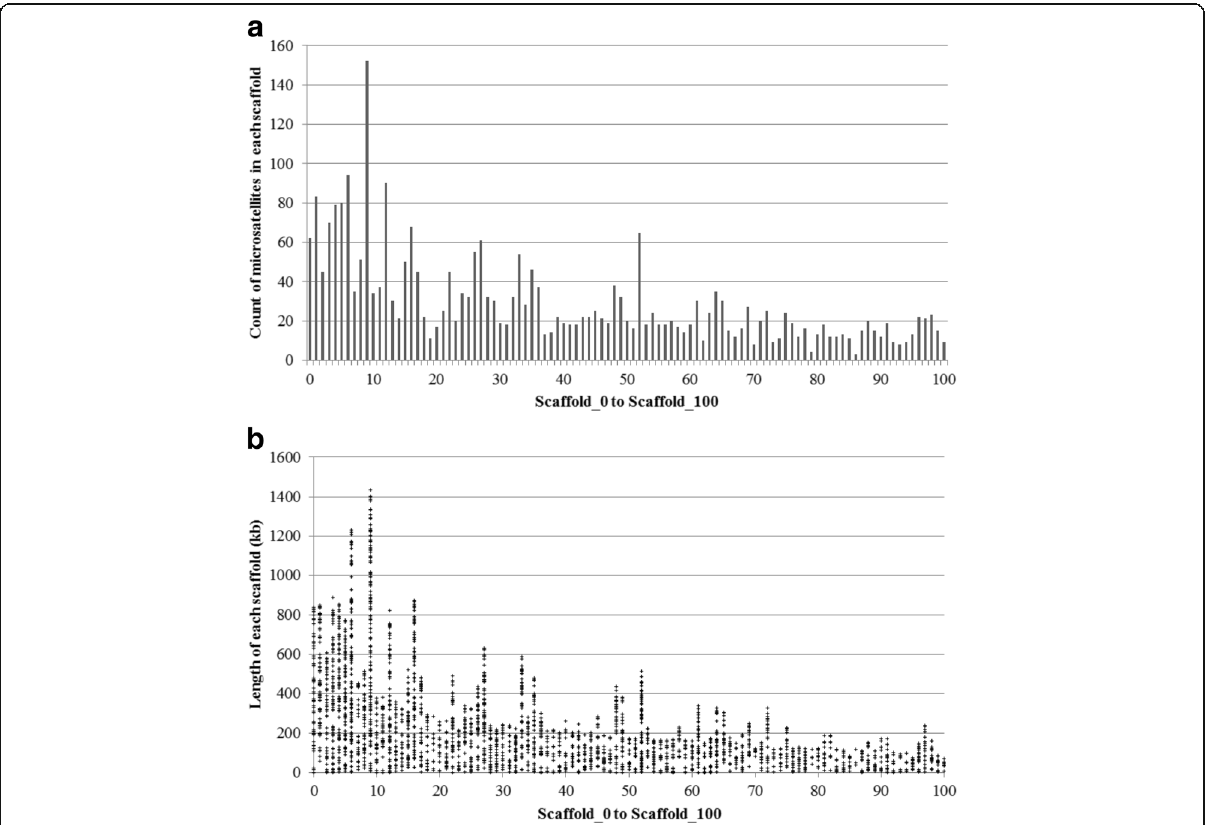
Fig. 3 Count ( a ) and distribution ( b ) of microsatellites on scaffold_0 to scaffold_100. The total length of the 101 scaffolds (0 to 100) is 31,436,433 bp, accounting for 85.15% of the total genome size and containing 80.10% of the microsatellites. Scaffold_9 is the longest (1,454,817 bp) and has the most microsatellites (152). In b, each cross mark represents a microsatellite at the corresponding position on that